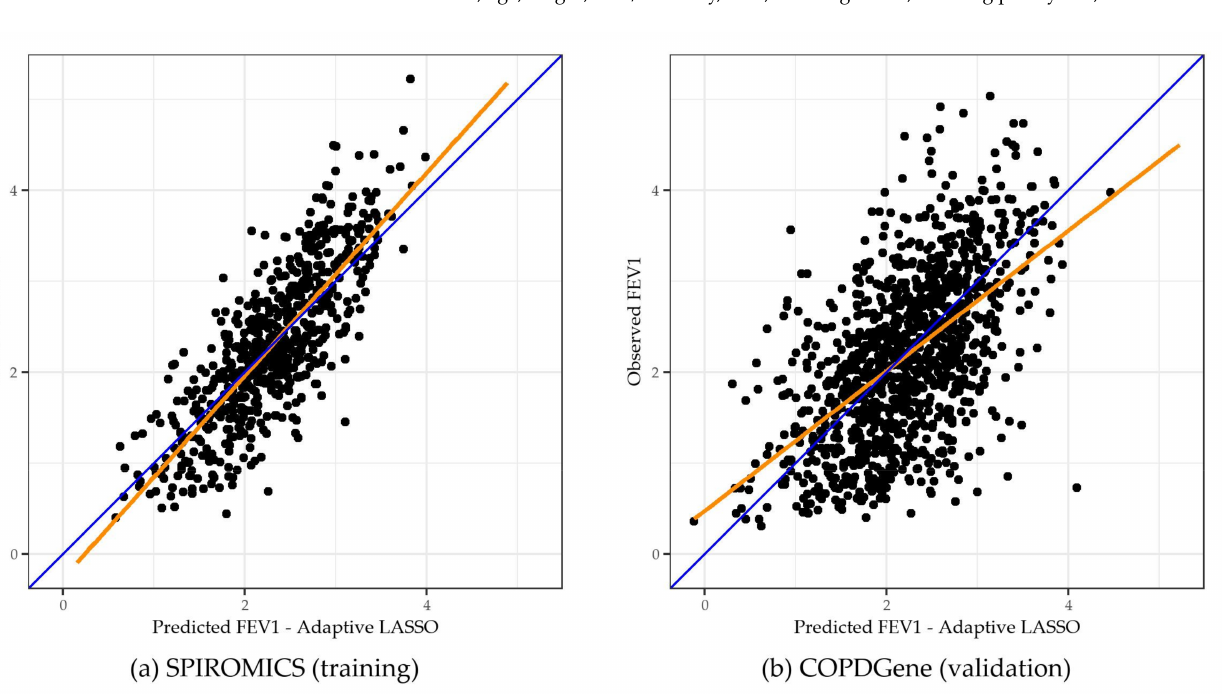
Figure 1. metSS Predicted vs. Observed FEV 1 for the Training ( a ) and Validation ( b ) Cohorts Adaptive LASSO-based metSS prediction of FEV1. Each point represents an individual’s predicted and observed FEV 1 . The blue identity line denotes a perfect prediction of FEV 1 . The orange line denotes the observed FEV 1 regressed on the metSS-predicted FEV 1